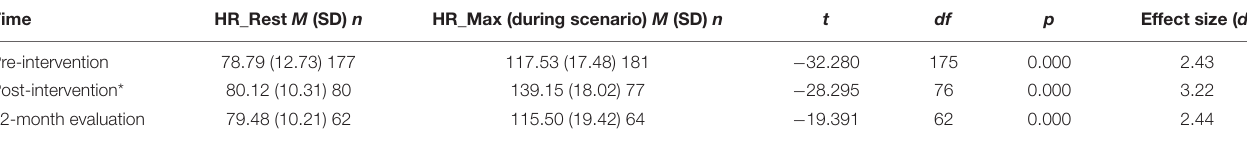
TABLE 2 | Manipulation check: stress responses to critical incident scenarios.